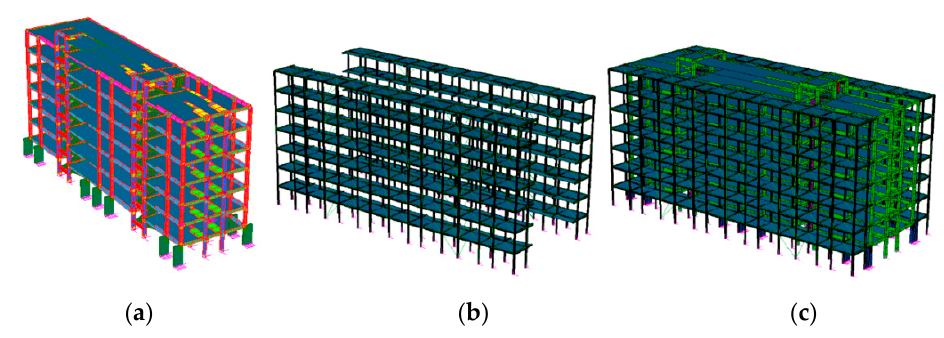
Figure 12. a) FE model of the structure without the retrofitting system; b) dissipative retrofitting system; and c) FE model of the retrofitted structure.